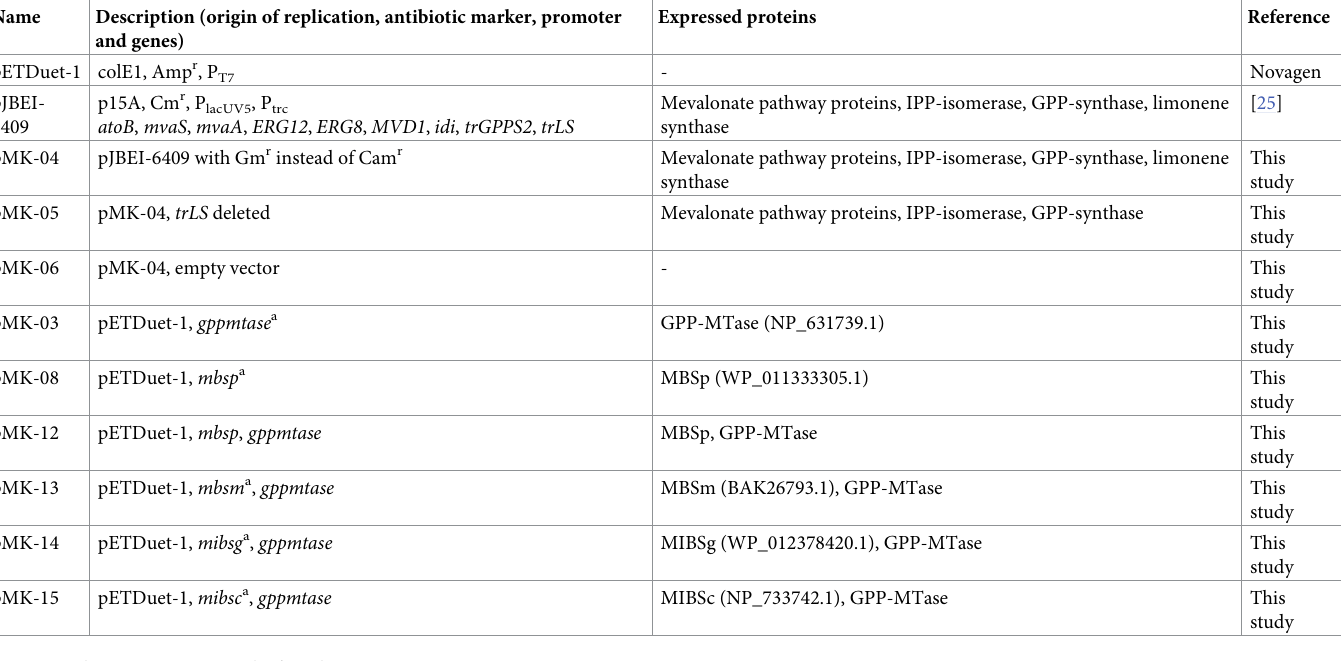
Table 1. Plasmids used in this